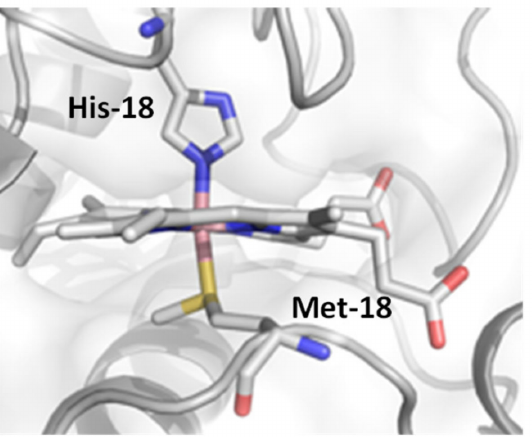
Figure 1. Crystal structure of Co-cyt c active site (PDB 1LFM). Highlighted residues are His/Met biaxial